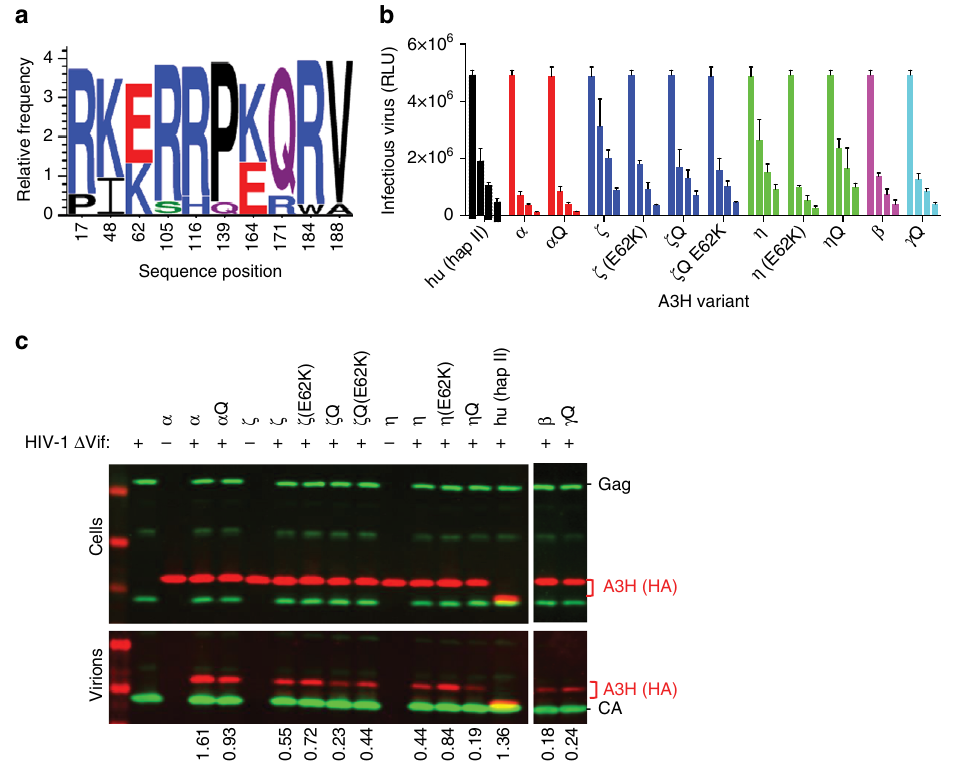
Fig. 1 A3H amino acid polymorphism. a Logo representation of A3H variants obtained from 14 pigtail macaques. Ten sites of variation were identi fi ed and at least 13 allelic variants were identi fi ed due to variation at multiple sites in some animals (Supplementary Fig. 1). b Antiviral activity of pgtA3H variants compared to huA3H (hap II). HIV-1 Δ Vif stocks were generated in the presence of increasing amounts of each HA-tagged A3H variant (0, 37, 75, 150 ng expression plasmid) and titrated on indicator cell lines expressing nanoluciferase under the control of the HIV promoter. Luciferase activity was measured and expressed as relative light units (RLUs). Mean and standard deviation of n = 2 independent experiments. c Virion incorporation of A3H variants. 293T cells stably expressing HA-tagged A3H variants were infected with HIV-1 Δ Vif. Infected cells and sucrose puri fi ed virion particles were analyzed by immunoblot. The speci fi city of virion incorporation was veri fi ed using supernatants from uninfected cells expressing selected A3H variants. Levels of A3H virion incorporation are shown under the gels and expressed as the ratio of the signals (arbitrary units) of A3H bands over viral capsid protein (CA)